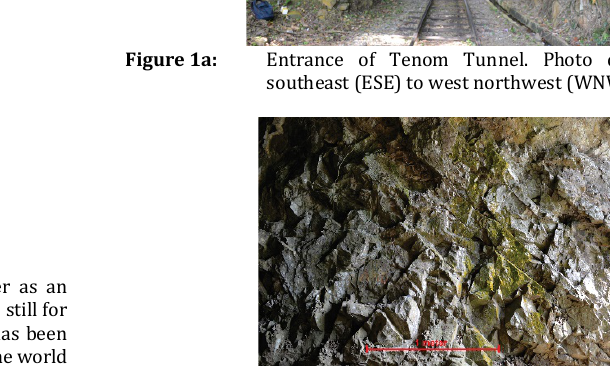
Figure 1b: Amalgamated thick sandstone unit of Crocker